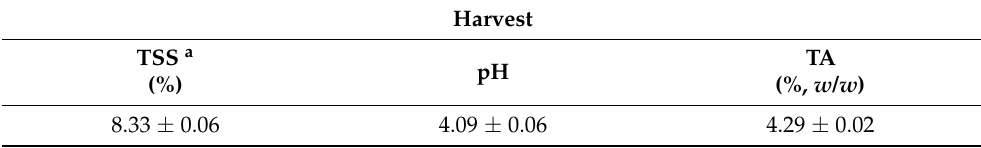
Table 1. Total soluble solids (TSS), pH values and titratable acidity (TA) of juice in cherries at harvest.